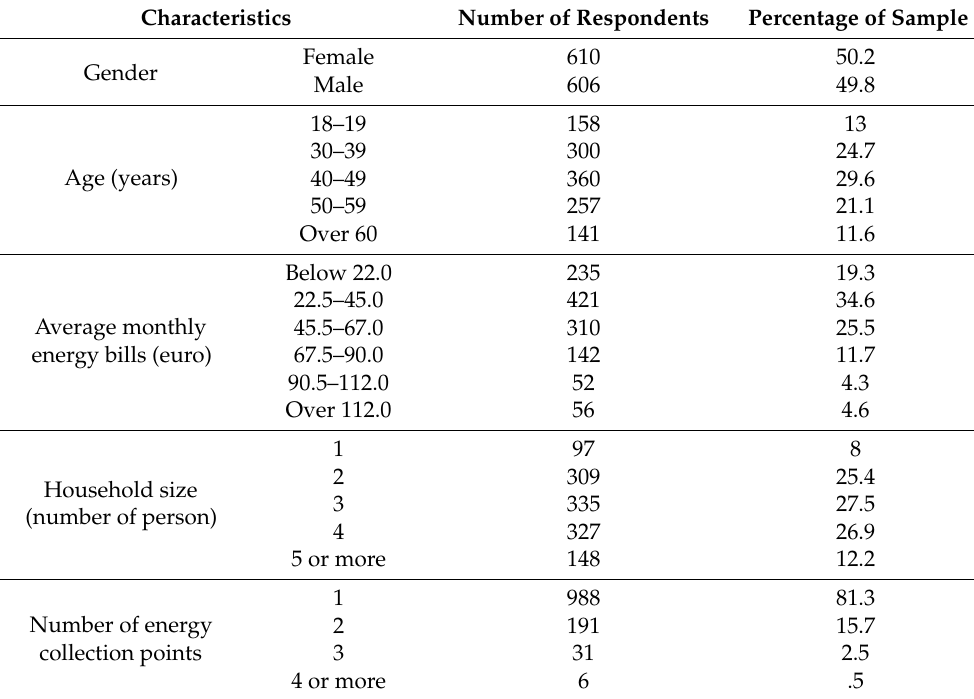
Table 2. Research sample